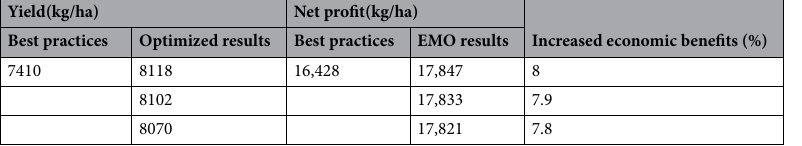
Table 6. Comparison of best simulated experimental results (sorted by net profit) and the best